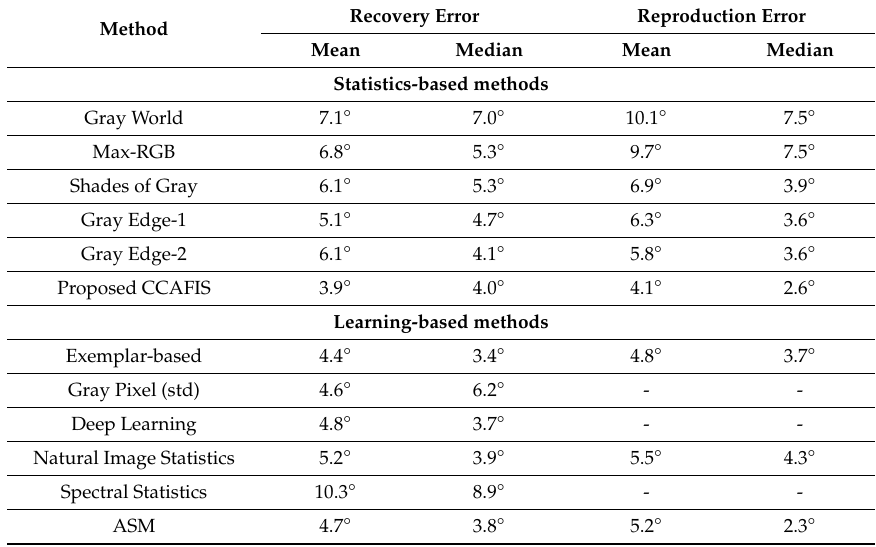
Table 3. Average mean and median recovery and reproduction angular errors of colour constancy methods’ images of the Grey Ball